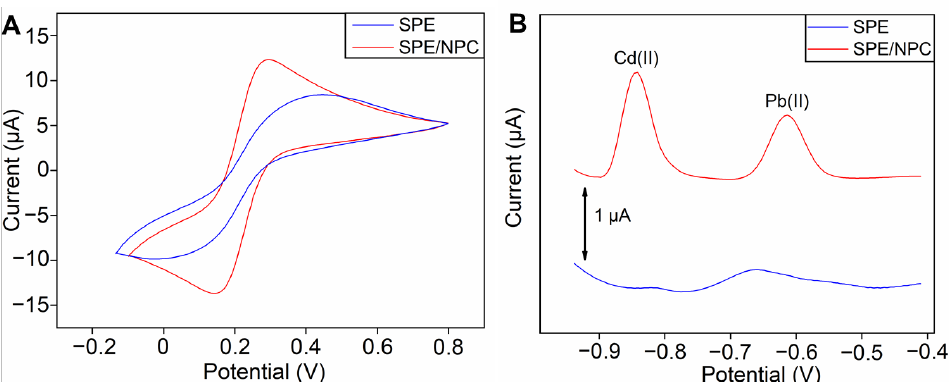
Figure 2. ( A ) Cyclic voltammogram curves of the bare SPE and prepared SPE/NPC in a 0.1 M KCl solution containing 1.0 mM K 3 [Fe(CN) 6 ]/K 4 [Fe(CN) 6 ]. ( B ) Stripping curves of the electrode before and after modification in acetic acid buffer solution containing Pb(II) and Cd(II) with a concentration of 30 µ g L − 1 and 0.81 mg L − 1 of